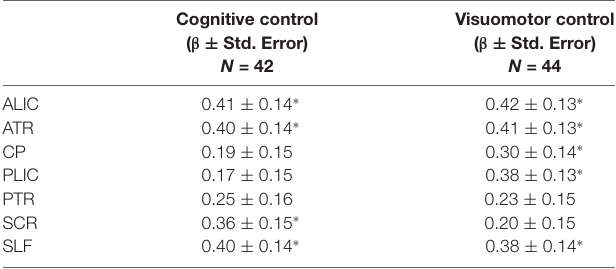
β value regression coefficients are reported to assess for strength of the relationship after controlling for cohort assignment. ALIC, Anterior Limb of the Internal Capsule; CP, Cerebral Peduncle; PLIC, Posterior Limb of the Internal Capsule; PTR, Posterior Thalamic Radiation; SCR, Superior Corona Radiata; SLF, Superior Longitudinal Fasciculus. ∗ Indicates FDR adjusted p-value ≤ 0.05 for regression